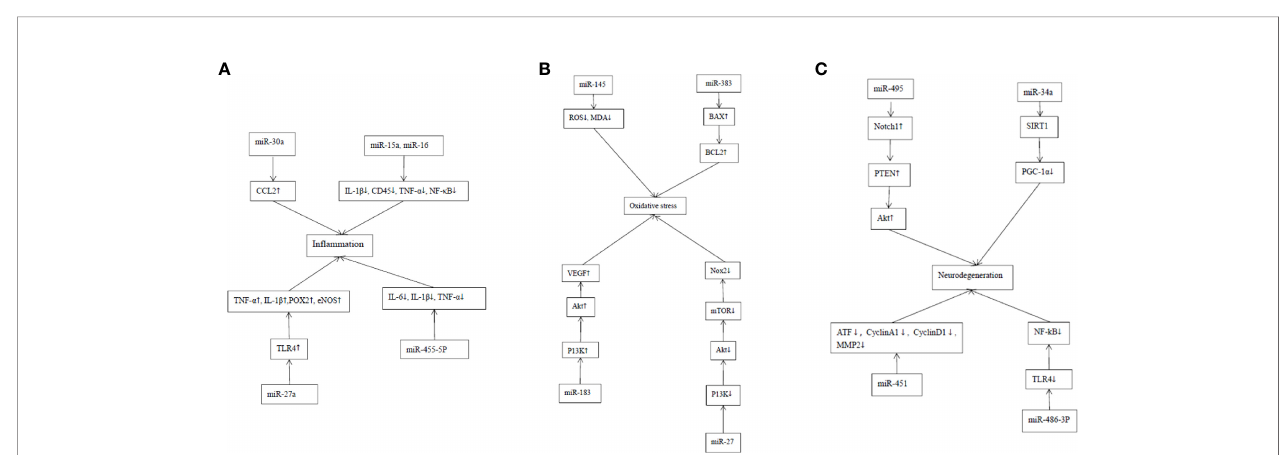
FIGURE 1 | Mechanism of action of MiRNAs in DR in fl ammation, oxidative stress and neurodegeneration. (A) Mechanism of action of MiRNAs in DR in fl ammation. The targeting of miR-30a to CCL2 in retina enhances the phagocytosis of microglia in the retina. MiR-15a and miR-16 can inhibit the proin fl ammatory signaling pathway and stasis of retinal white blood cells in DR by inhibiting IL-1 b , CD45, TNF- a and NF- k B. MiR-27a involves in the in fl ammatory response of DR by targeting TLR4 to stimulate the production of TNF- a and IL-1 b as well as pro-in fl ammatory proteins including cyclooxygenase-2 and inducible nitric oxide synthase. The up-regulation of MiR-455-5p signi fi cantly attenuated the HG-stimulated in fl ammatory response by inhibiting the release of in fl ammatory cytokines, such as IL-6, IL-1 b and TNF- a in ARPE-19 cells. (B) Mechanism of action of MiRNAs in the oxidative stress of DR. The overexpression of MiRNA-145 can reduce the levels of ROS and malondialdehyde (MDA) in cells, and increase the activity of superoxide dismutase, thus reducing hyperglycemia-induced oxidative stress and retinal endothelial cell apoptosis. MiRNA-383 can promote the production of ROS and induce apoptosis by increasing the expression of peroxidase redoxin 3 (PRDX3) and Bax/Bcl2. MiR-183 activates PI3K/Akt/VEGF signaling pathway, and increases CD34, endothelial nitric oxide synthase (eNOS) and ROS. MiR-27 inhibits Nox 2 signaling pathway by down-regulating P13K/AKT/mTOR, thus reducing the production of ROS. (C) Mechanism of action of MiRNAs in the neural degeneration of DR. MiR-495 affects the transmission of PTEN/Akt signal by targeting Notch1 and aggravates the damage to ganglion cells. MiR-34a promotes mitochondrial dysfunction and retinal microvascular endothelial cell senescence by inhibiting SIRT1/PGC-1 a axis and mitochondrial antioxidants TrxR2 and SOD2. MiR-451a protects mitochondrial function through down-regulation and activation of transcription factor 2 (ATF2) and its downstream target genes CyclinA1, CyclinD1 and MMP2. The up-regulation of miR-486-3P can protect Müller cells in the HG state from oxidative stress, in fl ammation and apoptosis by inhibiting TLR4/NF-kB axis.